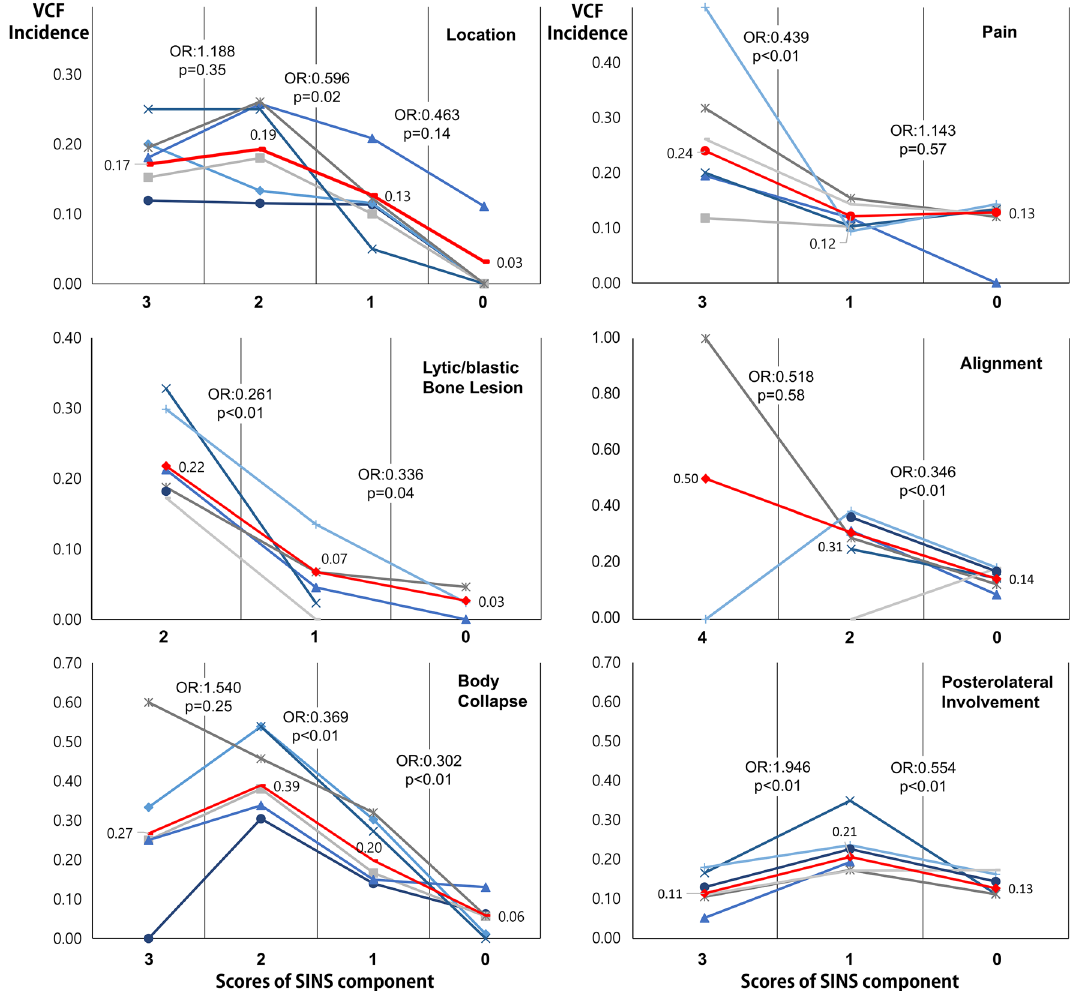
Figure 3. Incidence of vertebral compression fracture (VCF) after radiotherapy according to the score of each domain of the spinal instability neoplastic score (SINS). The red line shows the mean incidence rate. The lines with other colors represent each of the included studies. The lytic lesion (score 2) of bone lesion showed more frequent than the other lesions. In terms of the body collapse domain, the incidence decreased significantly as the score decreased, displaying high accuracy. Some domains and levels showed an increasing incidence of VCF despite decreasing scores. This figure was drown using Microsoft Excel version 2016.